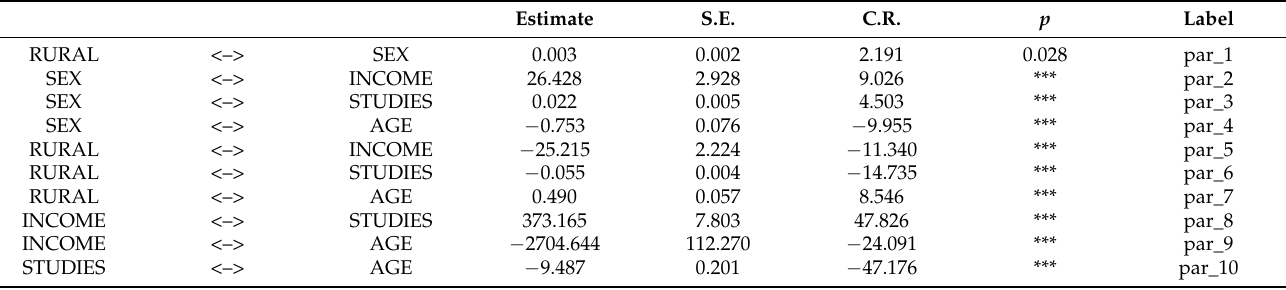
Table A9. Covariances: (Group number 1-Default model).